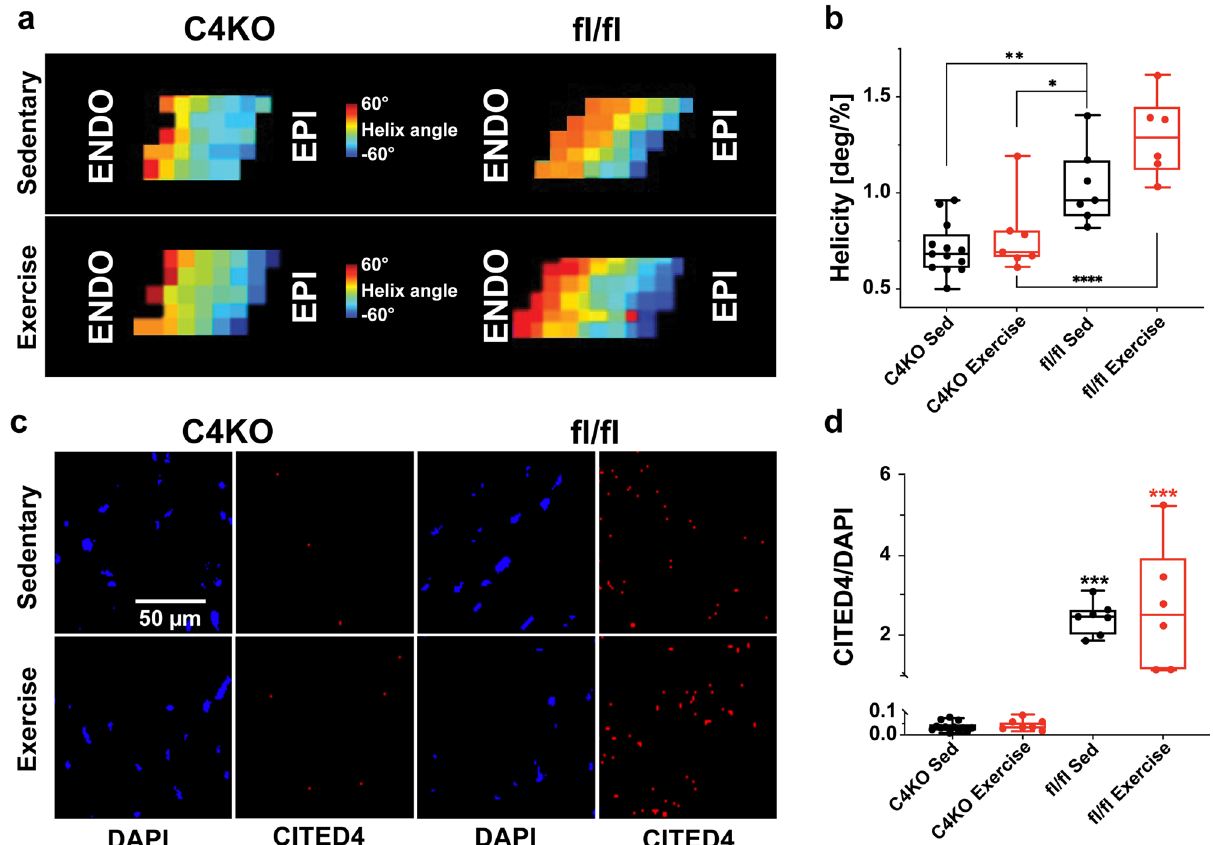
Fig. 6 Cardiomyocyte-speci fi c knock out of CITED4 impacts regional tissue helicity changes. a Helix angle changes differ signi fi cantly between groups. b An analysis of helicity between all groups of cohort 2. c Images of DAPI and CITED4 staining of representative mice from cohort 2. d Quanti fi cation of CITED4/DAPI using RNA-FISH with cohort 2. Two-way ANOVA used for multivariant analyses * P < 0.05, ** P < 0.01, *** P < 0.001. Data are presented min to max. Within each box, horizontal black and red lines denote median values; boxes extend from the 25th to the 75th percentile of each group ’ s distribution of